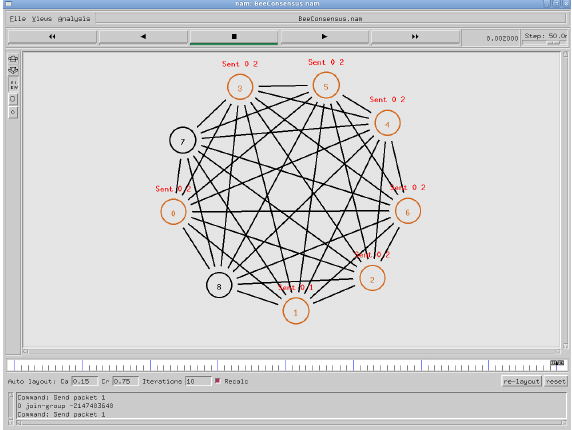
Figure 15. NS2 Simulation with a handful of network nodes Network Animator (NAM) is a tool embedded in NS2 to visualize simulation. Figure 15 depicts an example of multicast network nodes in NAM, a circle represents a network node and a line between one pair of nodes corresponds to a link between them. In a multicast scenario, every node is connected to all other